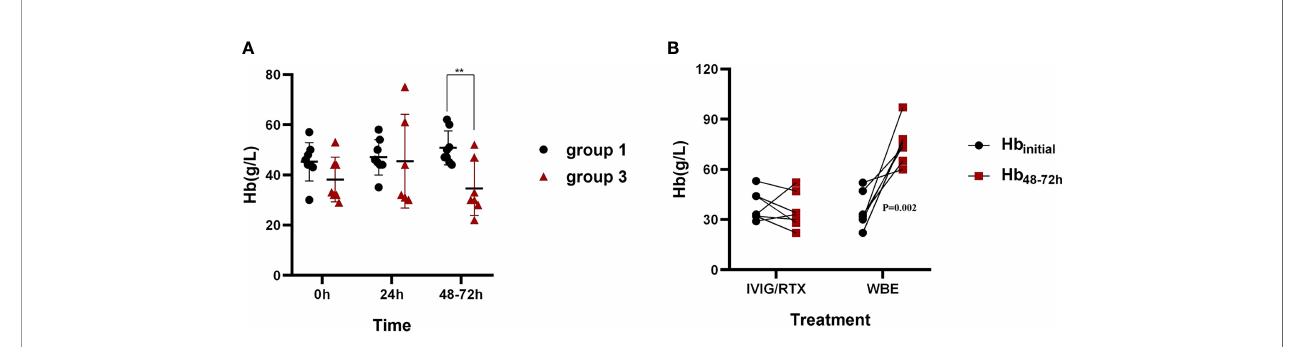
FIGURE 4 | Hb levels in 48 – 72 h after corresponding therapies in groups 1 and 3. (A) The comparison of Hb levels in 48 – 72 h after IVIG/RTX treatment between groups 1 and 3. (B) The changes of Hb levels at 48 – 72 h after IVIG/RTX and WBE treatment of group 3. Hb initial is the Hb level when IVIG/RTX or WBE therapy begins. Data are shown as the mean ± SD. Each dot plot represents an individual patient, ** p < 0.01. Group 1 (IVIG/RTX, n = 8), group 3 (IVIG/RTX ! WBE, n = 7).